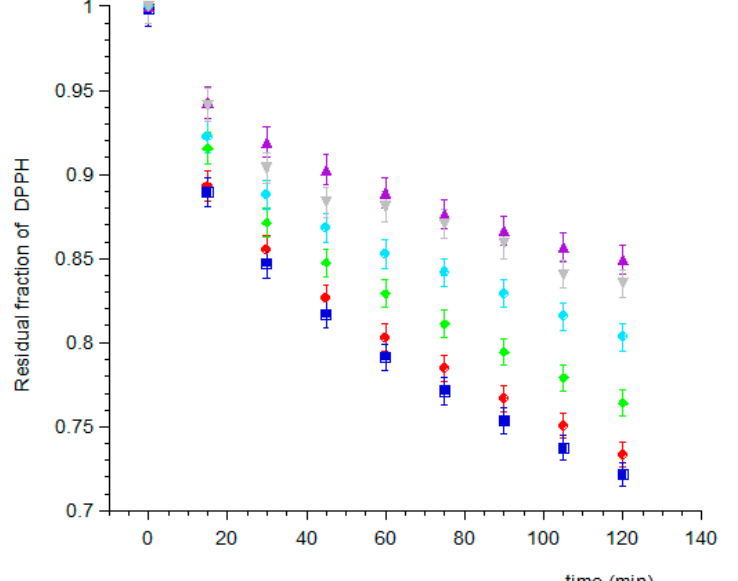
Figure 1. Residual DPPH concentration as a function of time in the different samples of treated AFA solutions: ( (cid:72) ) Methanol in ultrasound bath; ( • ) Methanol in homogenizer; ( (cid:78) ) Methanol in homogenizer and filtered; ( (cid:117) ) Ethanol in ultrasound bath; ( (cid:4) ) Ethanol in homogenizer; and ( (cid:117) ) Ethanol in homogenizer and filtered.